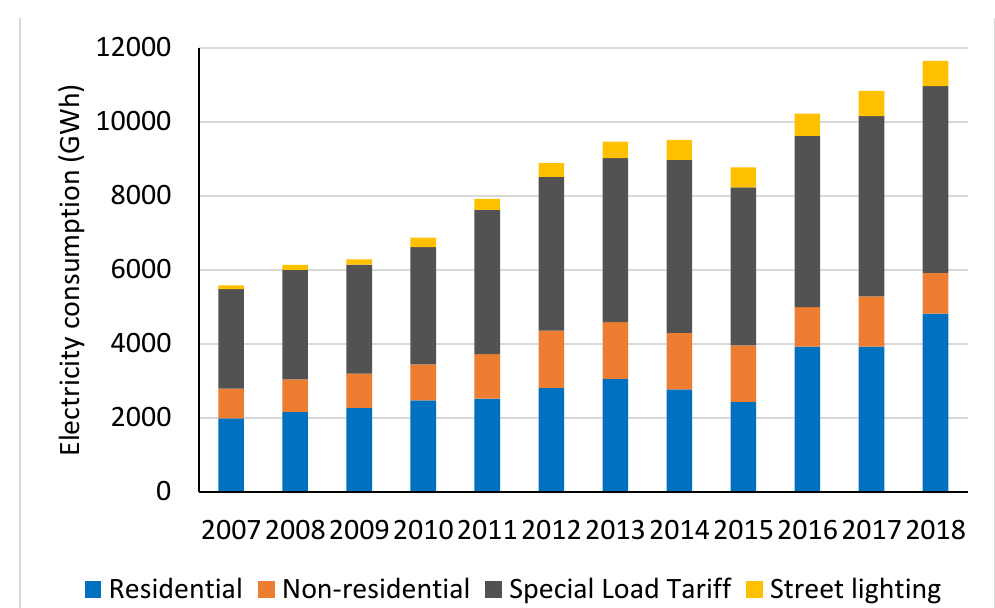
Figure 2. Trends in Ghana’s annual electricity consumption by sector, 2007–2018 [47,49].